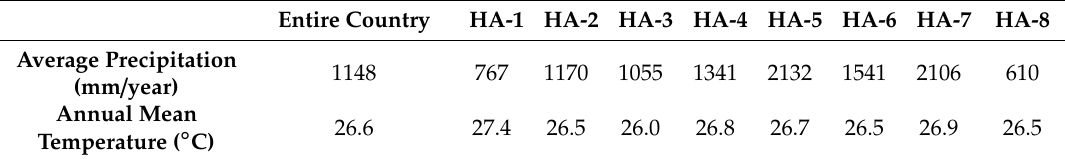
Figure 1. Map of Nigeria showing Hydrological Areas (HAs) and transboundary basins (Niger, Lake Chad, Cross, Akpa, and Oueme). Source: JICA-FMWR, 2014; Mc Cracken andWolf, 2019 [4,5]. Table 1. Average spatial temperature and precipitation in hydrological areas in Nigeria (1960–2009).